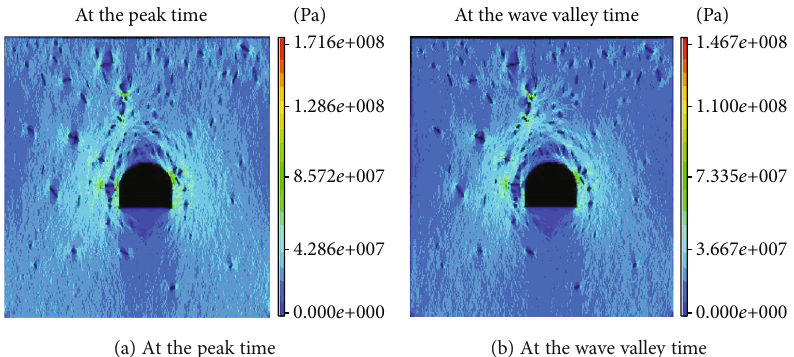
Figure 9: Maximum principal stress evolution process in the fi rst cycle.